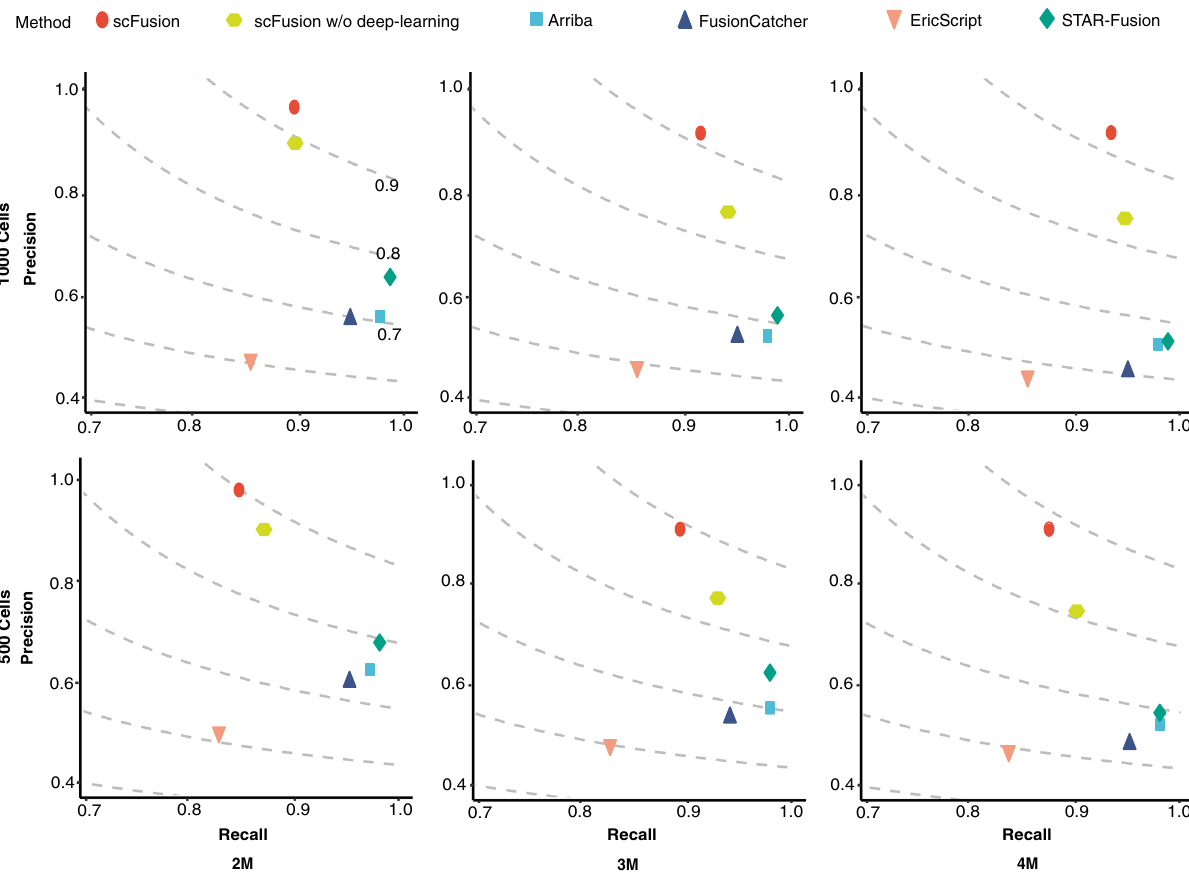
Fig. 3 The precisions and recalls of scFusion, scFusion without the deep-learning model, and four bulk methods in six different simulation setups. The fi gures in the two rows correspond to simulations with 1000 cells and 500 cells, and the fi gures in the three columns correspond to simulations with 2 million, 3 million, and 4 million reads in each data. The dots in the fi gures are the means of precisions and recalls of ten simulations in each setup. The dashed lines are the contour lines with constant F-scores (F-scores are marked in the top-left fi